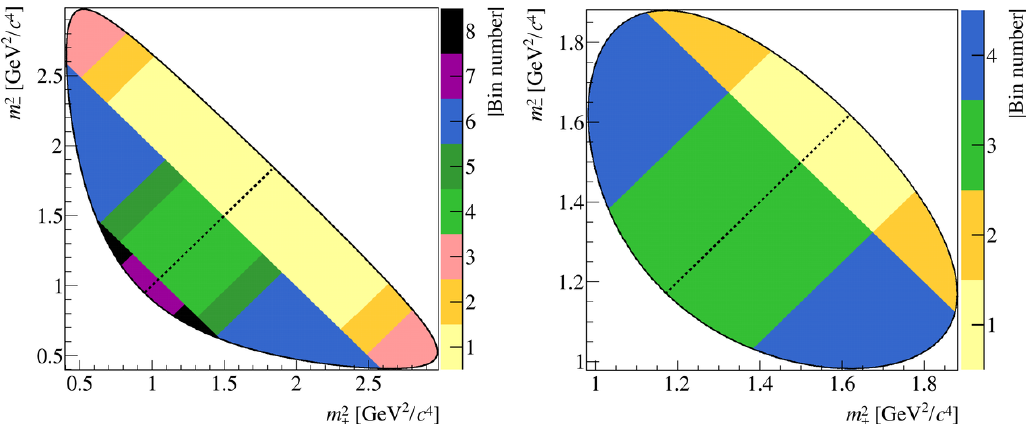
Figure 9 . Rectangular binning schemes for (left) D ! K 0 decays. The diagonal line separates the positive and negative bins, where the positive bins are in the region in which m 2